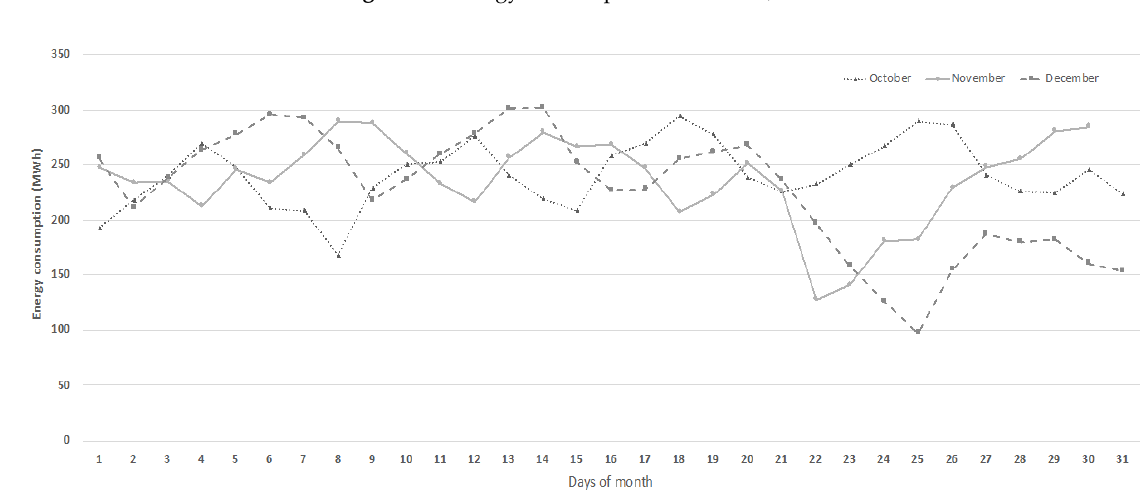
Figure 10. Energy consumption in summer, 2018.